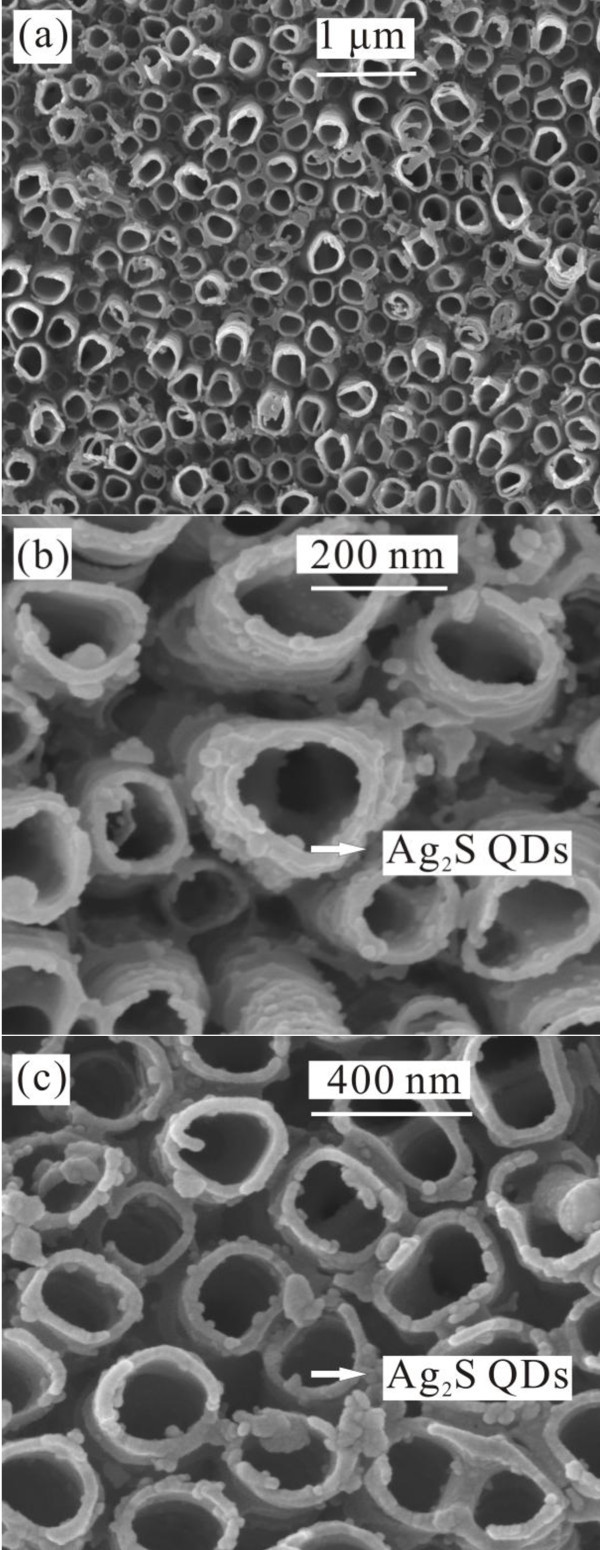
SEM images of (a) the plain TNTs, (b) Ag2S(4)/TNTs, and (c) Ag2S(4)/ZnO/TNTs.